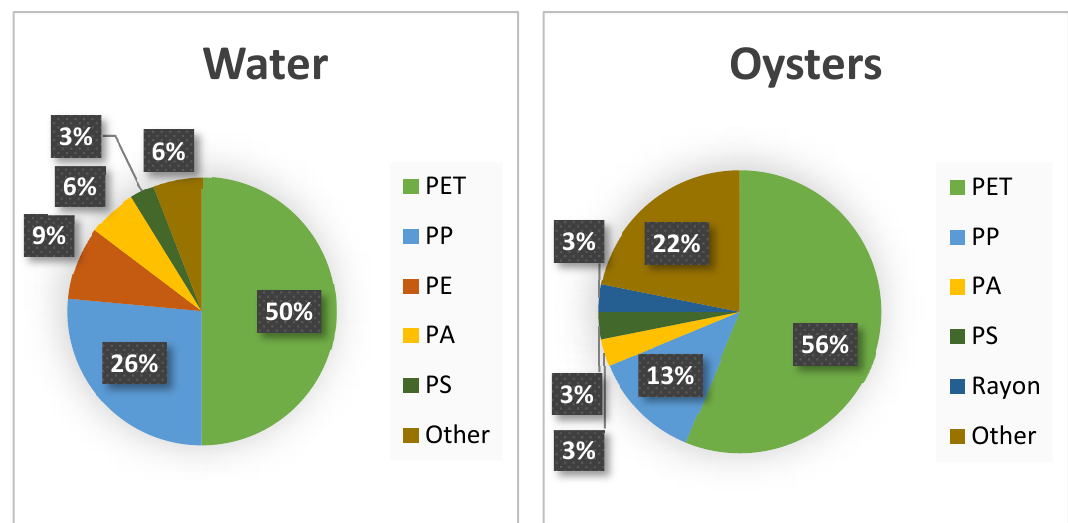
Figure 4. Synthetic polymers in microplastics from water and oysters from the Indian River Lagoon. Polymers are polyethylene terephthalate (PET), polypropylene (PP), polyethylene (PE), polyamide (PA), polystyrene (PS), rayon, and miscellaneous polymers (Other).